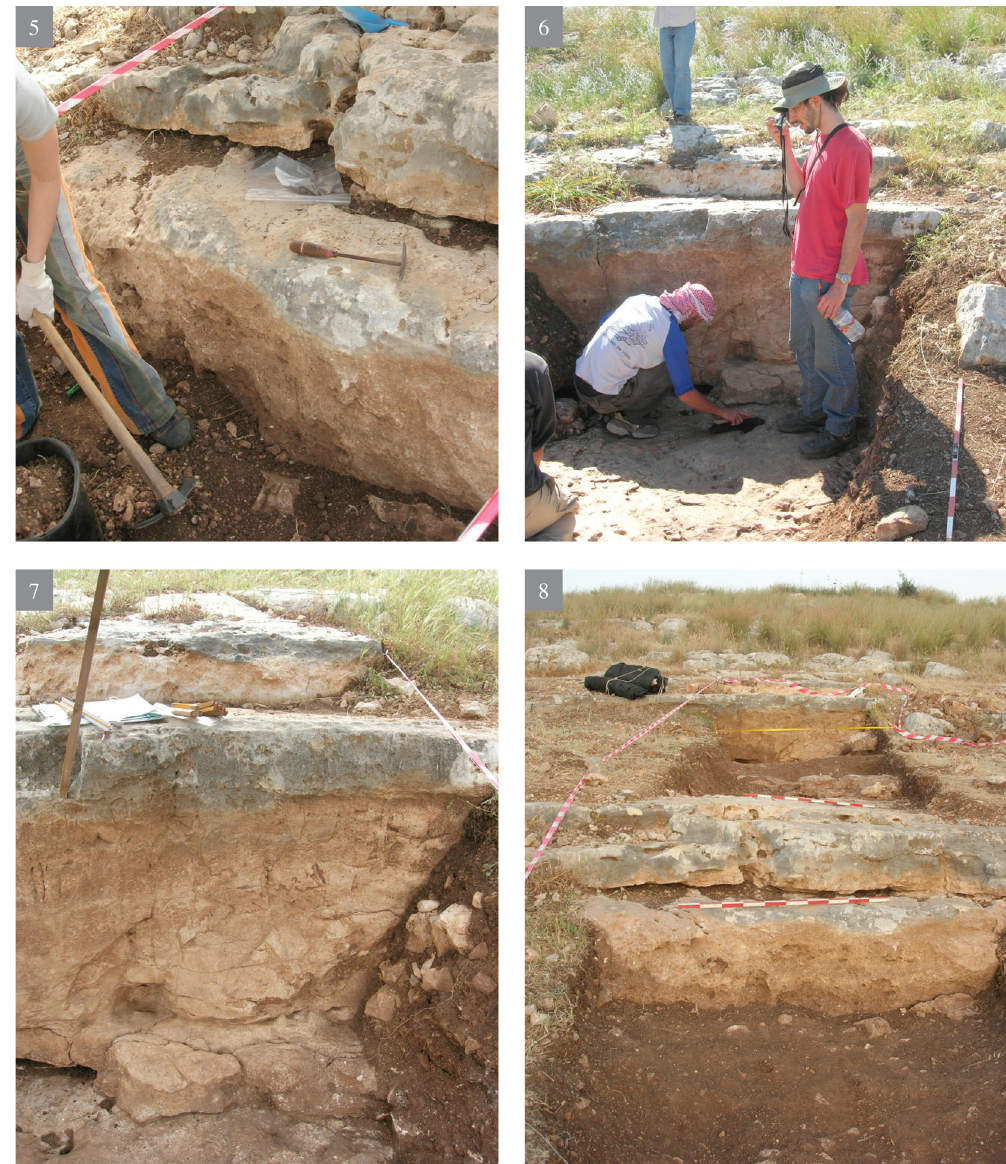
Fig 11. The excavation trench. (5–8) exposure of quarrying